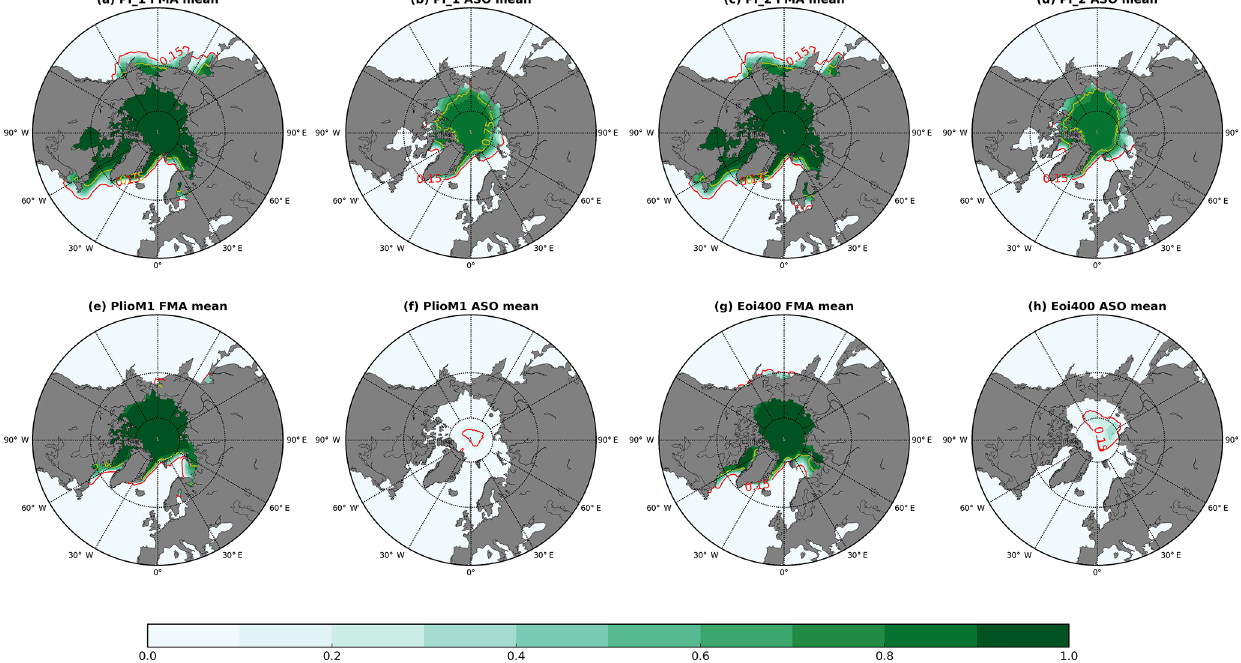
Figure 11. Seasonal mean Arctic sea ice concentration averaged over 100 model years as simulated by COSMOS for mid-Pliocene and PI runs in response to boundary conditions prescribed for PlioMIP1 and PlioMIP2. Panels (a) , (c) , (e) , and (g) show winter (FMA) averages, while panels (b) , (d) , (f) , and (h) show summer (ASO) averages for simulations PI_1, PI_2, PlioM1, and Eoi400, respectively. The red contours indicate the 15% isoline of sea ice cover, while yellow contours indicate the 75% isoline of sea ice